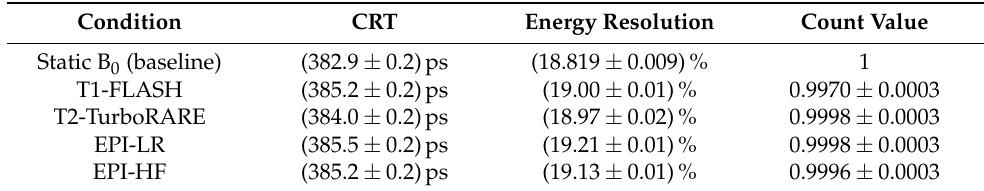
Table 4. CRT, energy resolution and count value (observed coincidences normalized by expected counts, relative to baseline) in high decay rate (range 491.7–521.1MBq) PET data acquisition during simultaneous MRI